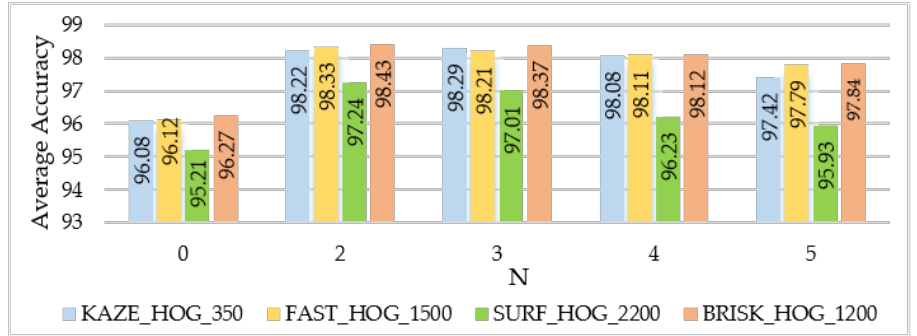
Figure 9. Average accuracy with respect to number of neighbors N for visual expression codebook creation for the NTOU-MMR dataset using the sparse-random coding model and Mahalanobis